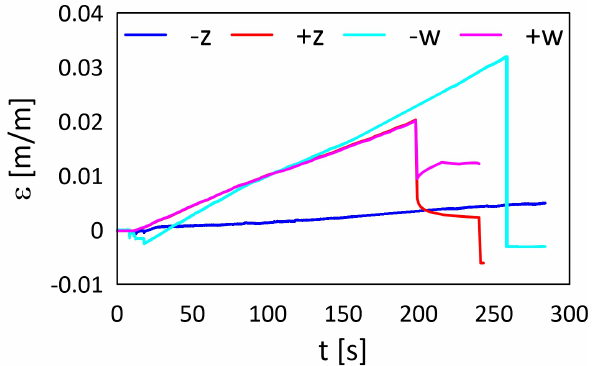
Figure 21. Strain determined for RW samples manufactured from M3 X during the tensile test: w —embedded, z —attached, ‘+’—after exposure on elevated temperatures, and ‘ − ’—after exposure on sub-zero